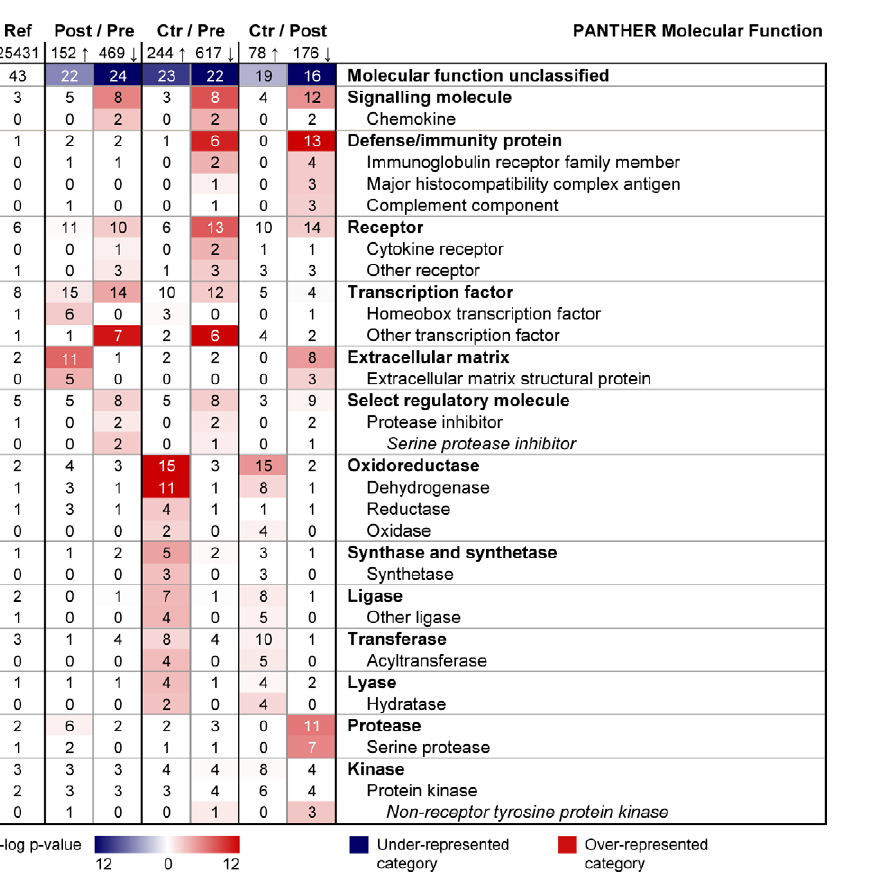
Figure 3. Functional categorization of differentially expressed genes in subcutaneous adipose tissue after fat loss (Molecular Function). PANTHER was used to search for over-represented Molecular Function categories among the most differentially expressed genes (q- value=0, fold change $ 1.5), comparing adipose tissue before versus after bariatric surgery (n=16) and versus controls (n=13). The color intensity displays the statistical significance ( 2 log p-value) of over- and under-represented PANTHER functional categories. A p-value , 0.01 with Bonferroni correction for multiple testing was used as inclusion criterion for categories. Numbers presented in the table indicate the percentage of genes within a gene set that map to the given category, e.g. 8% of the 469 down-regulated genes map to the molecular function ‘Signalling molecule’. The first column states the overall distribution of a term among all human NCBI genes (25,431), e.g. 3% of the genes are expected to map to ‘Signalling molecule’, hence this category is significantly over-represented among the down-regulated genes. Ref, reference (based on all human NCBI genes); Pre, pre-surgery biopsies; Post, post-surgery biopsies; Ctr, biopsies of lean controls; Arrow up, up-regulated/more expressed genes; Arrow down, down-regulated/less expressed